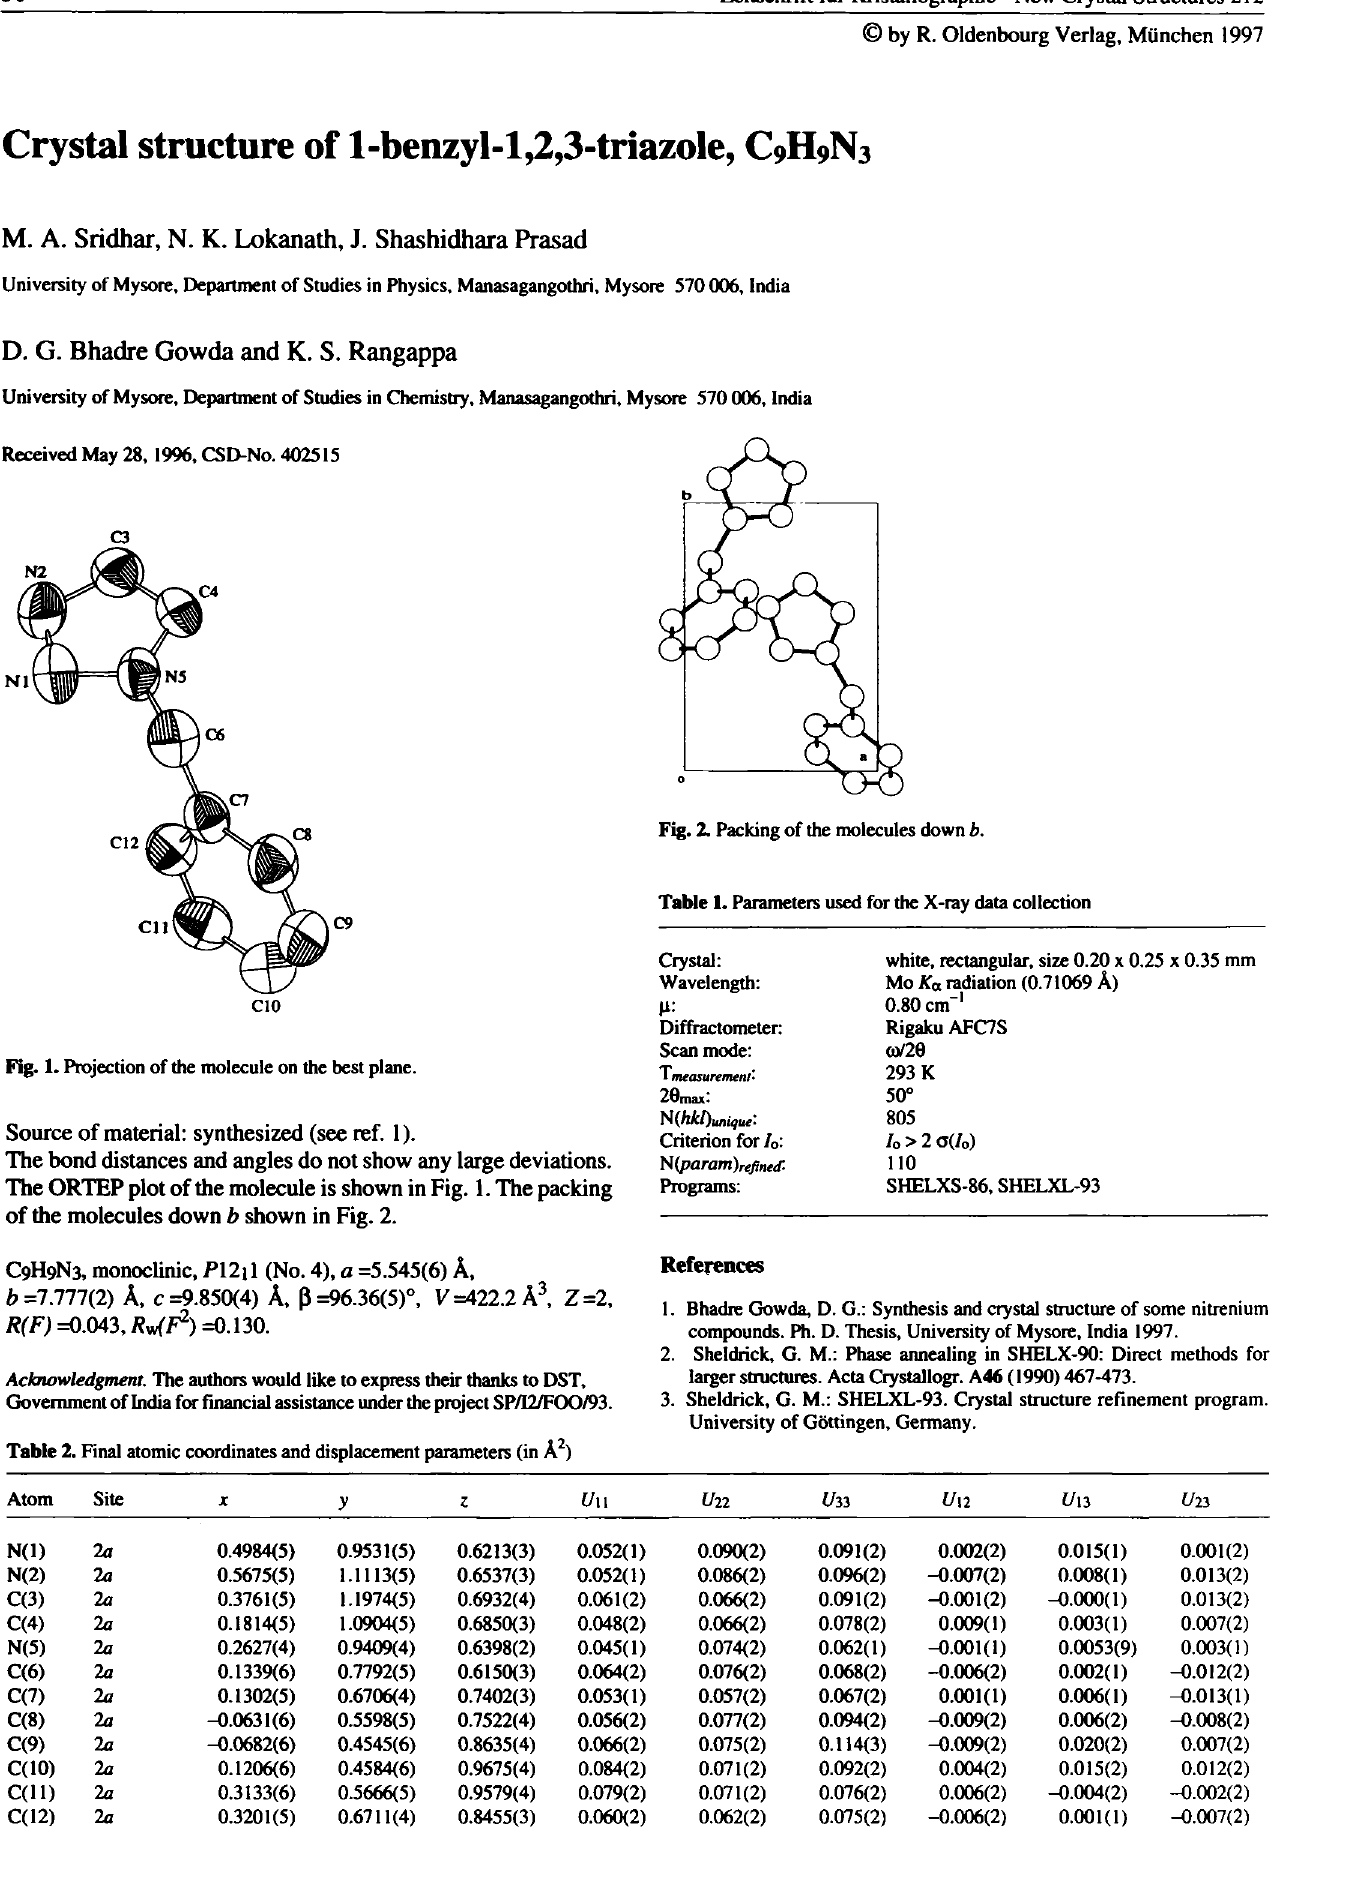
Fig. 1. Projection of the molecule on the best plane. Source of material: synthesized (see réf. 1).